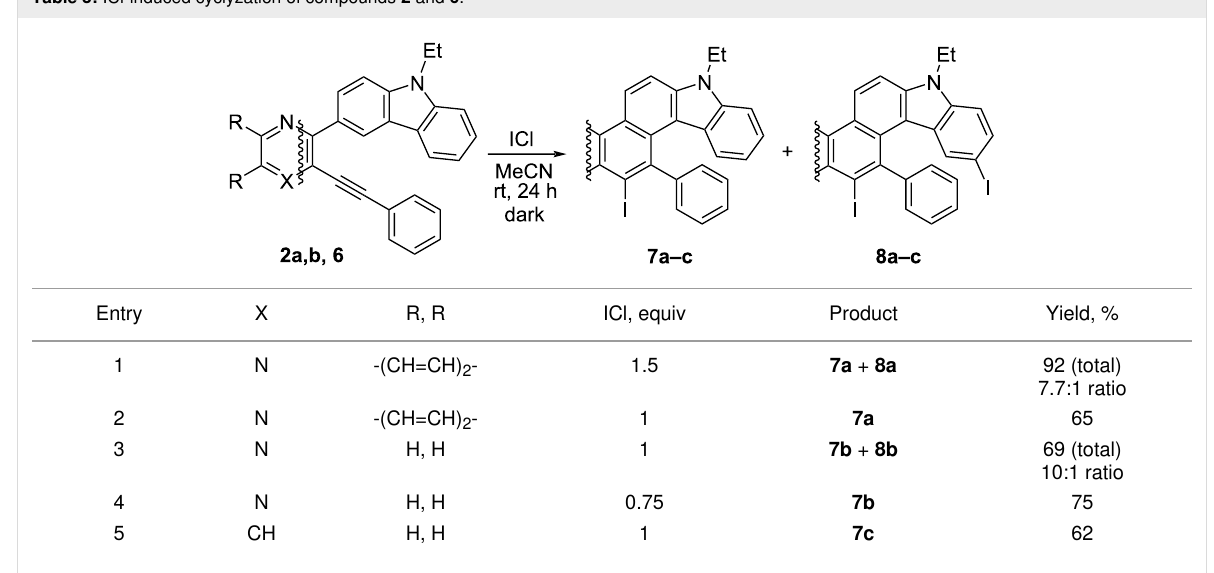
thesis of 7b , iodine chloride was taken in a small deficit (Table 3, entries 3 and 4). Compound 8b was synthesized in 97% yield by the treatment with a 3-fold excess of ICl on monoiodide 7b . The ICl-induced cyclization of the pyridine- based starting compound 6 proceeded smoothly giving rise to product 7c in 62% (Table 3, entry 5). It should be noted that compounds 7a , 7b and 7c are derivatives of the previously unknown heterocyclic systems 1 H -carbazolo[3,4- a ]phenazine, 7 H -quinoxalino[5,6- c ]carbazole and 7 H -quinolino[8,7- c ]carbazole, respectively (SciFinder